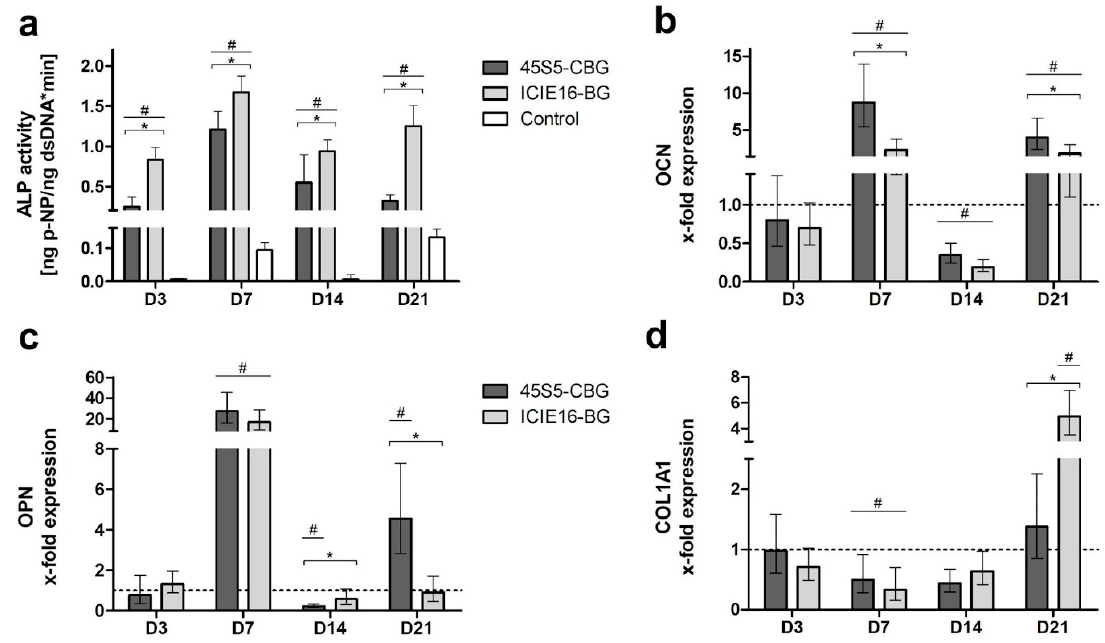
Figure 3. Alkaline phosphatase (ALP) activity ( a ) and expression of osteocalcin (OCN) ( b ), osteopontin (OPN) ( c ), and type I collagen alpha 1 (COL1A1) ( d ). Gene expression was normalized to the control (shown as a dotted line). Values are presented as means with standard deviation. # indicates significant differences to the control group and * indicates significant differences between the BG groups being encompassed by brackets.